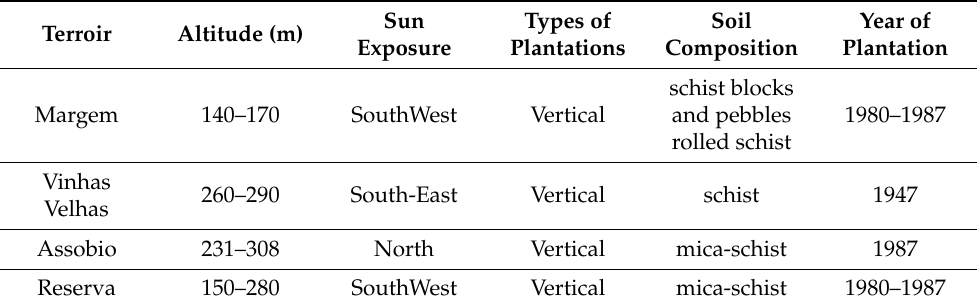
Figure 1. Quinta dos Murças from the wine company Esporão, located at Alto Douro Wine Region map illustration (https://www.esporao.com/pt-pt/sobre/quinta-dos-murcas/; accessed on 17 January 2023). VV—Vinhas Velhas. Table 1. Terroir geographical and soil characteristics. In all terroirs the grapevines were conducted in the